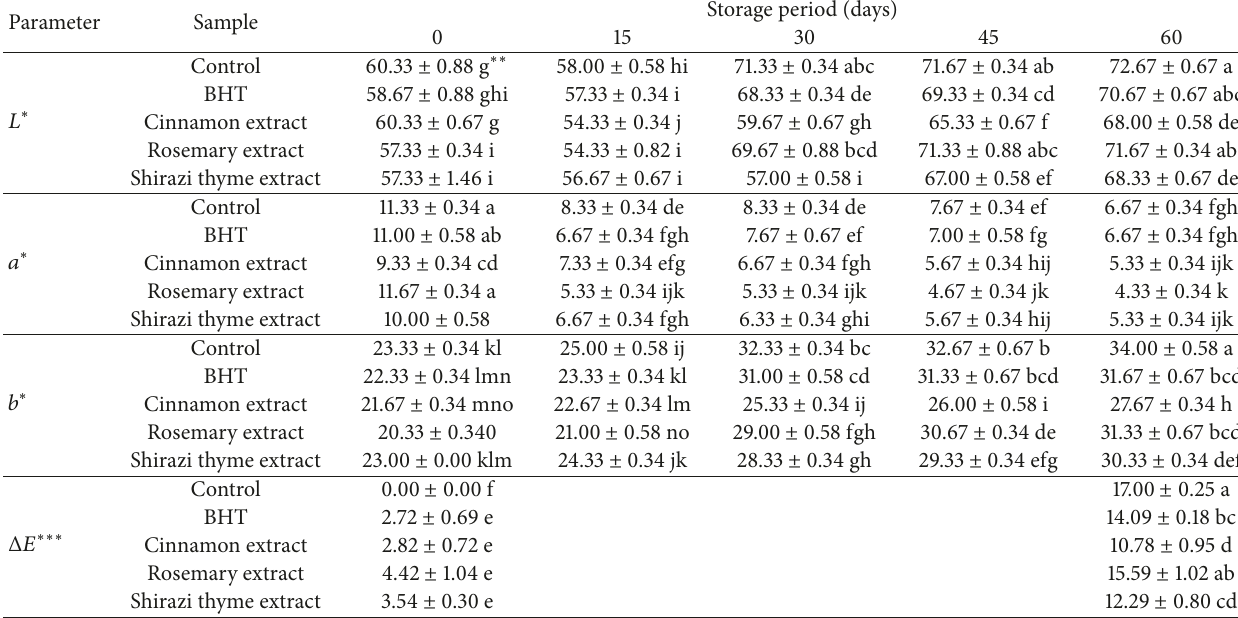
Table 1: Effect of addition of Shirazi thyme, cinnamon, and rosemary extracts and BHT on 𝐿 ∗ , 𝑎 ∗ , 𝑏 ∗ ,and Δ𝐸 values of raw beef burgers during frozen storage at − 18 ∘